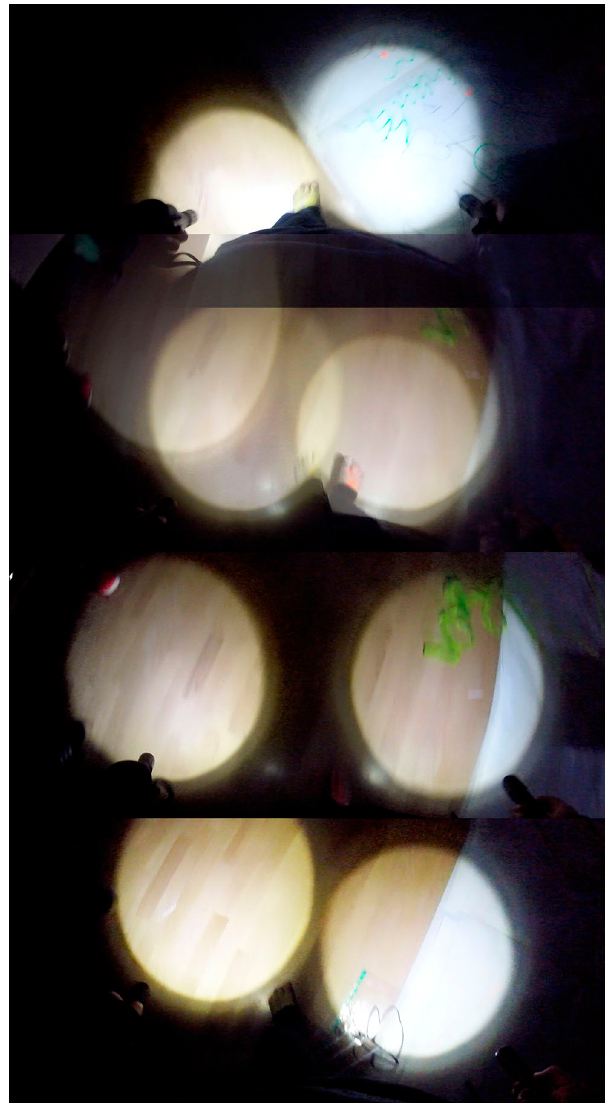
Figure 4. Light and shadows: A six year old boy walks holding two torches, one in each hand, around the perimeter of the paper. As the projected circles separate, join, merge, the painted feet step in and out of their projected circles. Now the fluorescent paint on the skin glimmers, now it disappears.